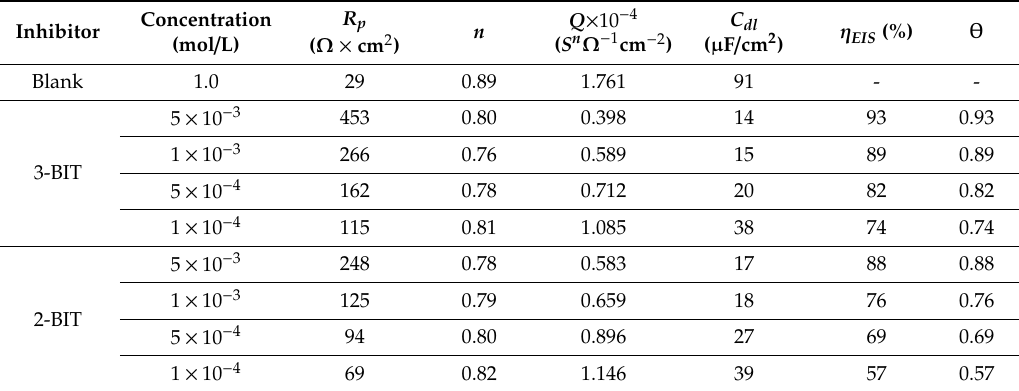
Table 3. Electrochemical impedance spectroscopy (EIS) results recorded for MS in the acidic medium at several concentrations of 3-BIT and 2-BIT at 303 K.